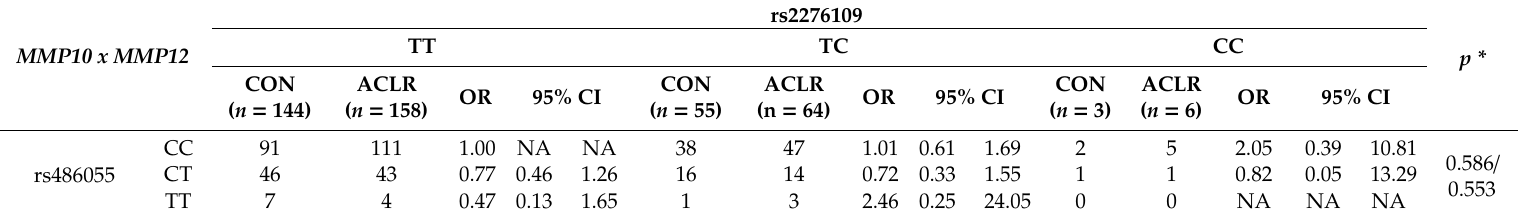
Table 5. Association analysis of the MMP10 x MMP12 interaction with non-contact ACL rupture (codominant model).